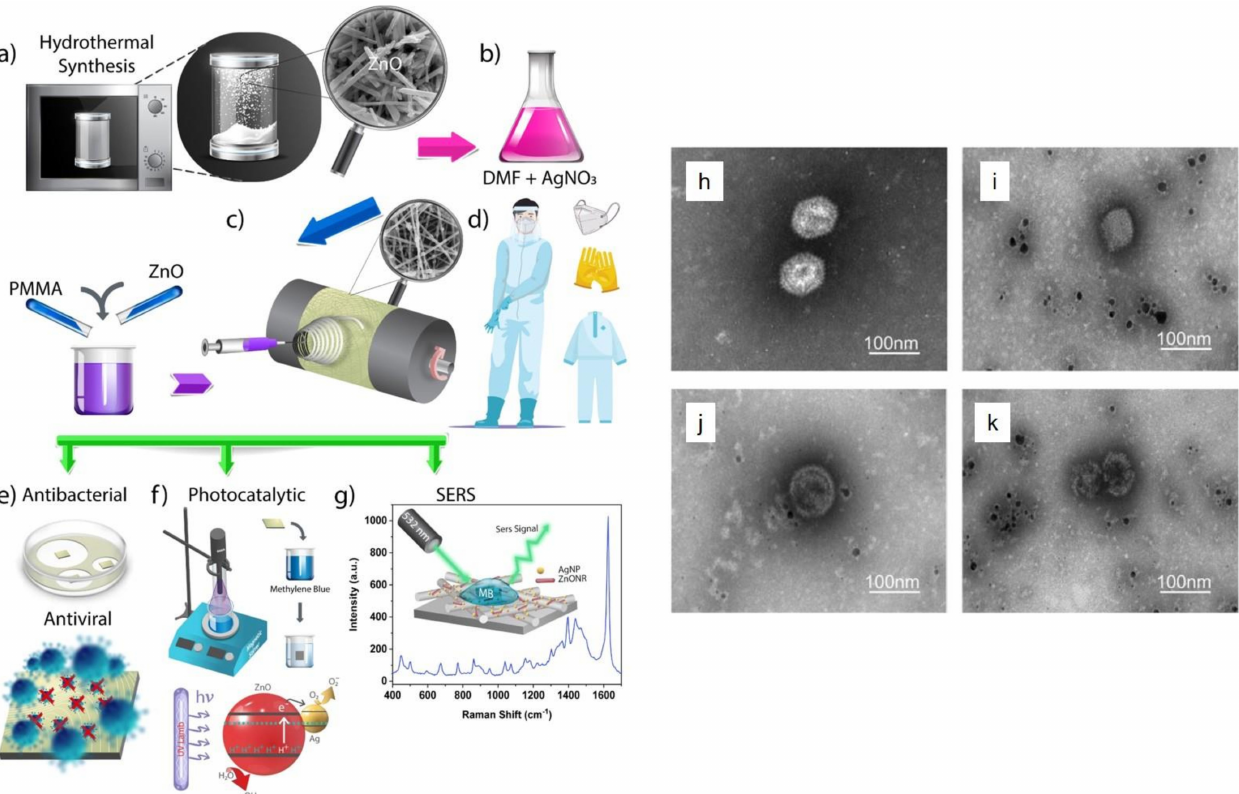
Figure 8. Schematic demonstration of the fabrication process of ZnO–Ag/PMMA nanofiber: ( a ) hydrothermal synthesis of ZnO nanorods. The inset image represents their morphology, ( b ) production of the electrospinning solution through addition of ZnO nanorods and PMMA to the AgNO 3 /DMF solution wherein Ag nanoparticles form via in situ reduction of the Ag salt, ( c ) creation of the ZnO–Ag/PMMA nanofibers through electrospinning, ( d ) the mats comprising the ZnO- Ag/PMMA nanofibers are employed as a protective clothing, and offer antimicrobial ( e ), photocatalytic ( f ), and sensing ( g ) properties. Reproduced with permission [144], Copyright 2021, American Chemical Society. TEM images show how the Ag nanoparticles adversely affect the Ad3 particles at different intervals. ( h ) Control sample in the absence of Ag nanoparticles; the samples treated with Ag nanoparticles (50 µ g/mL) for 30 min ( i ), 90 min ( j ) and 120 min ( k ). As clearly observed, the capsid and the whole virus particle have been notably destructed in the presence of the nanoparticles. Reproduced with permission [158] Copyright 2013,